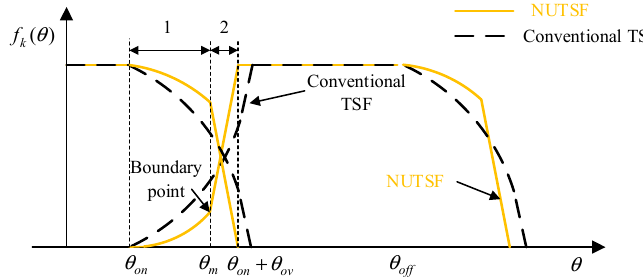
Figure 8. Comparison between conventional TSF and proposed NUTSF. The th-power of 1 P and 2 P are determined by the optimization algorithm of the TSF. Whether the th-power of 1 P and 2 P is changed depends on whether the torque error is within the specified range. The shape of the TSF is adjusted further; therefore, torque ripple will reduce further. The control flow chart is shown in Figure 9. Firstly, the 1 P and ( ) 2 P are input, and then the torque error formula is used to ob- initial values ( ) 0 0 T Δ and T Δ in regions 1 and 2, and the torque error formula tain the torque error values 1 2 is obtained from Formula (8)